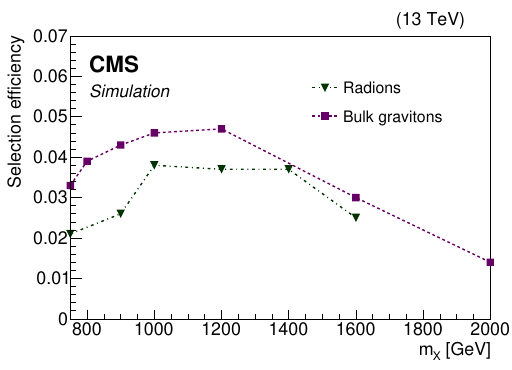
Figure 3 . The signal selection e(cid:14)ciencies for the radion and the bulk graviton, for di(cid:11)erent masses. The events are required to pass the selections given in table 2 as well as to fail the selections of the fully-merged analysis of ref. [39].